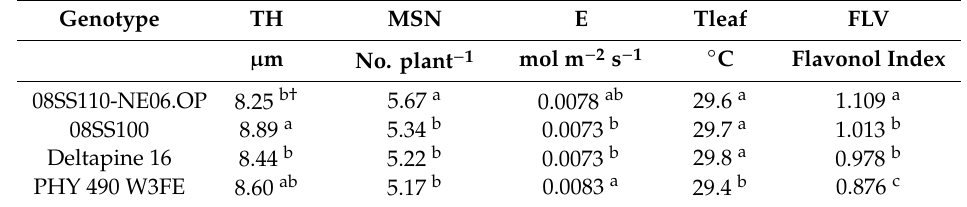
Table 4. Genotype e ff ect on leaf thickness (TH), main stem node (MSN), transpiration rate (E), leaf